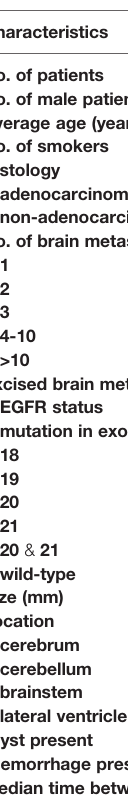
TABLE 1 | Patient and brain metastasis